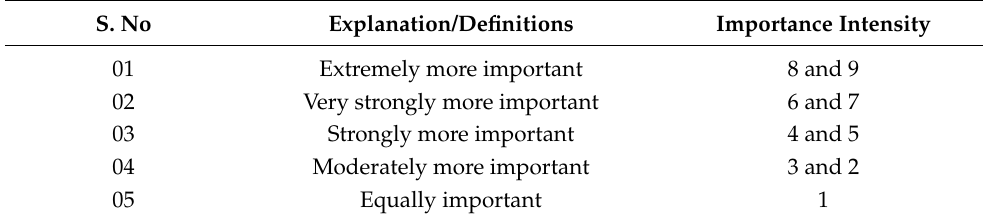
Table 2. Comparison of two factors that can induce flooding in the form of a numerical scale. S. No Explanation/Definitions Importance Intensity 01 Extremely more important 8 and 9 02 Very strongly more important 6 and 7 03 Strongly more important 4 and 5 04 Moderately more important 3 and 2 05 Equally important